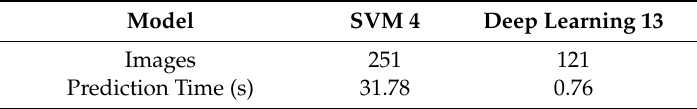
Table 6. SVM and deep-learning prediction time.